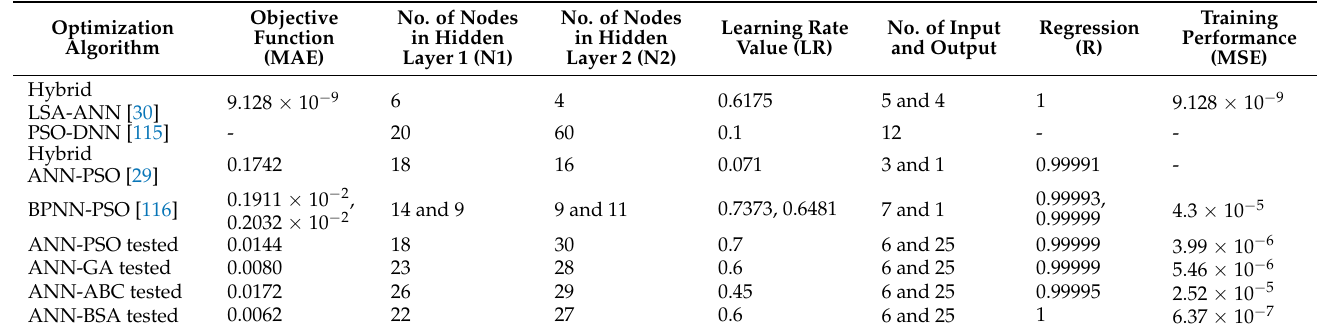
parameters of No. of nodes in hidden layers and learning